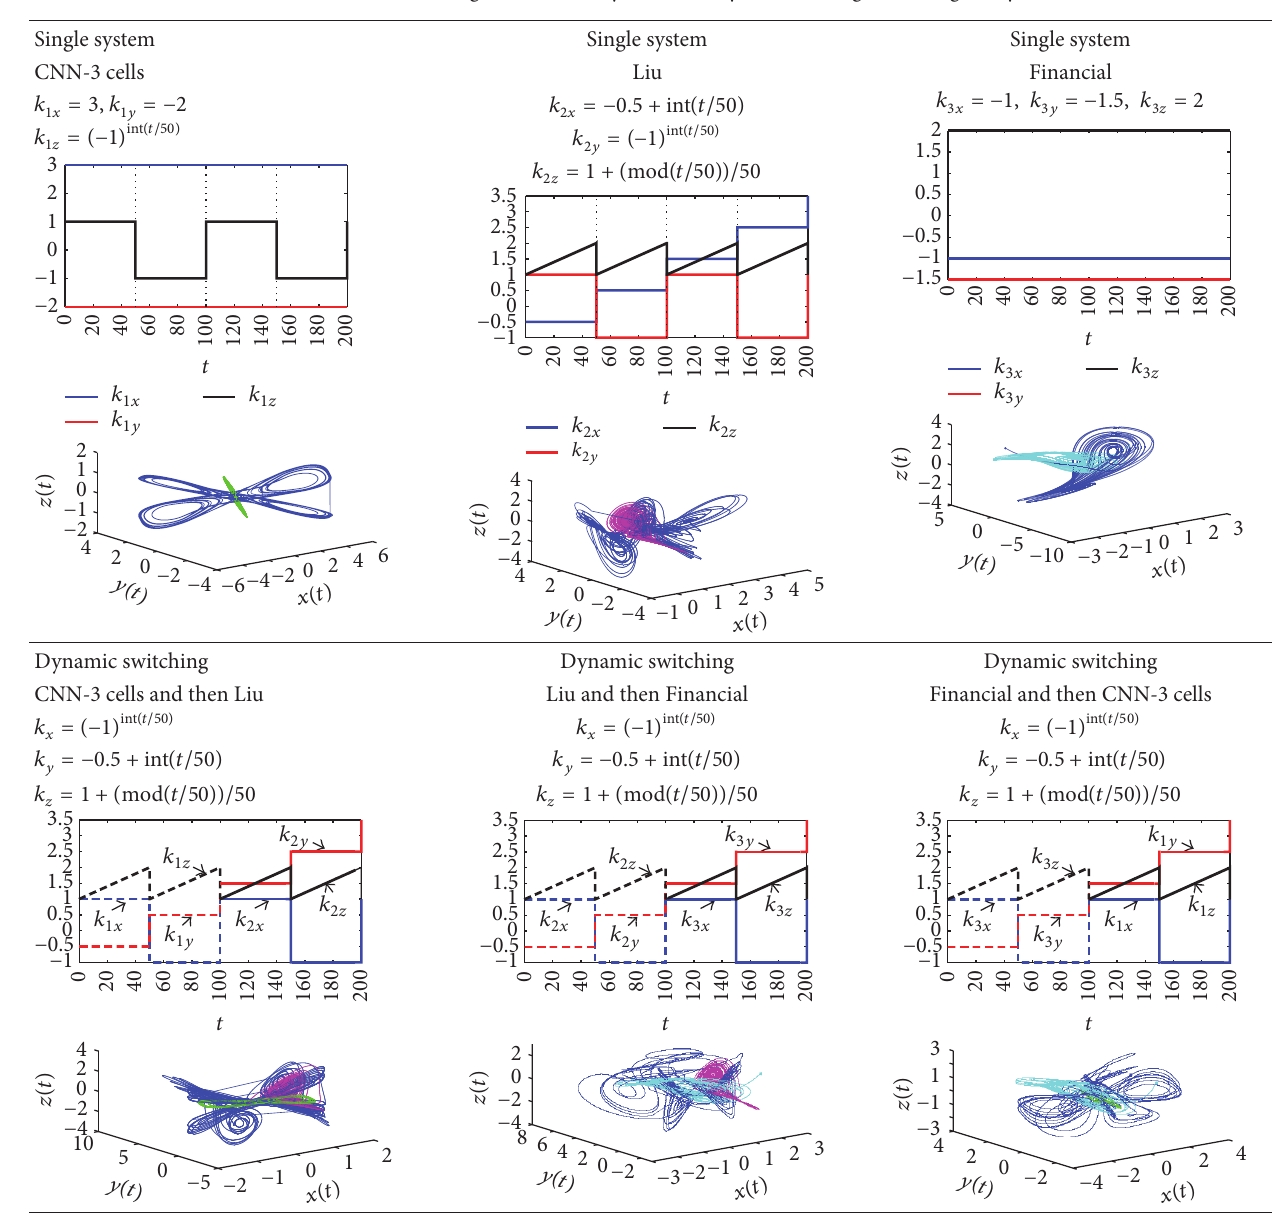
Table 4: New attractor diagrams formed by static and dynamic scaling of the original